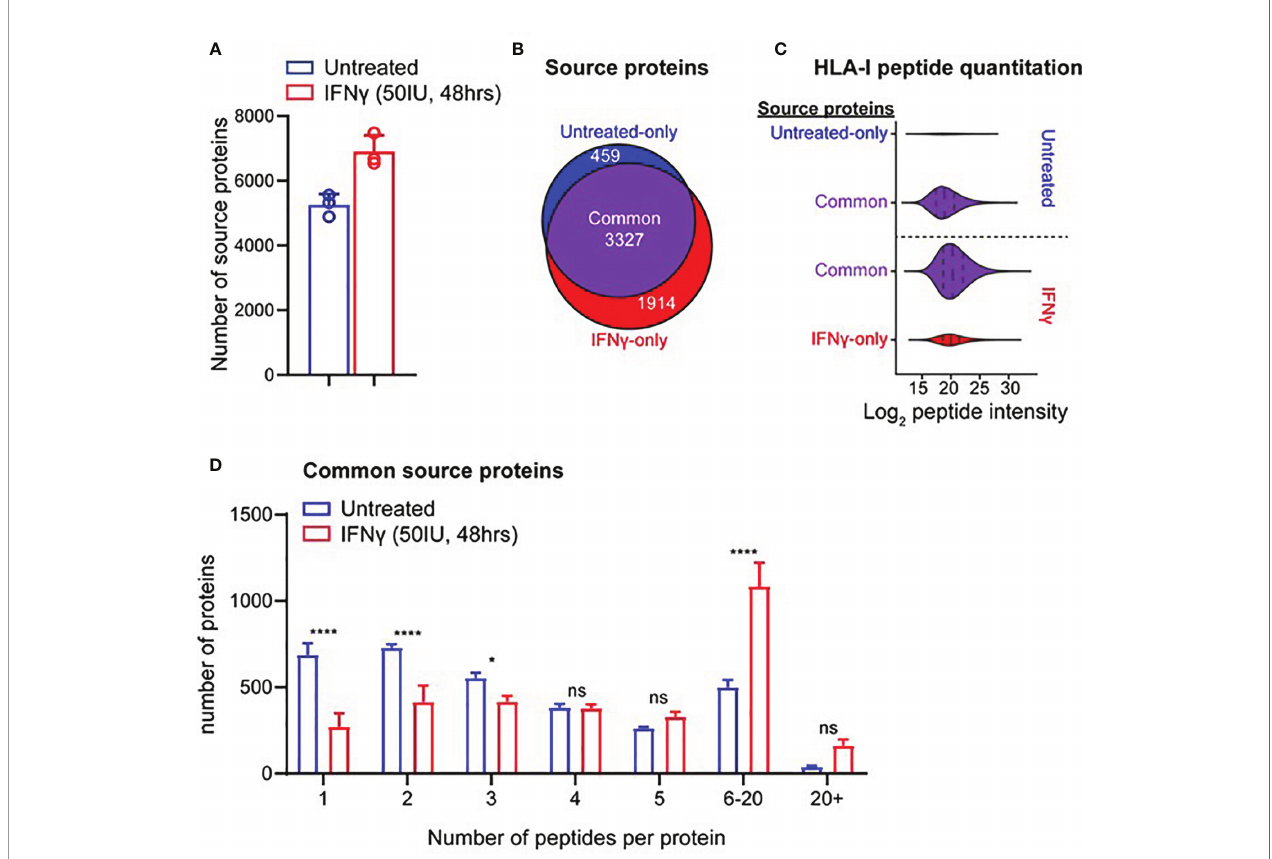
FIGURE 2 | IFN g causes considerable remolding of the source protein immunopeptidome landscape of TNBC cells. (A) Source proteins of HLA-I peptides identi fi ed across three biological replicates of IFN g treated (mean of 6,897 proteins) and untreated samples (mean of 5,256 proteins). (B) Comparative analysis of source protein overlap between untreated and IFN g treated cells. (C) HLA-I source peptide log 2 intensity calculated from label free quanti fi cation from common and unique HLA-I source proteins. (D) Histogram of number of HLA-I peptides per source protein under untreated or IFN g treated conditions. All data are from three biological replicates with mean ± SD and statistical analysis was performed by using a two-way ANOVA and signi fi cance is highlighted by ****(p < 0.001). * P < 0.1, ns, not signi fi